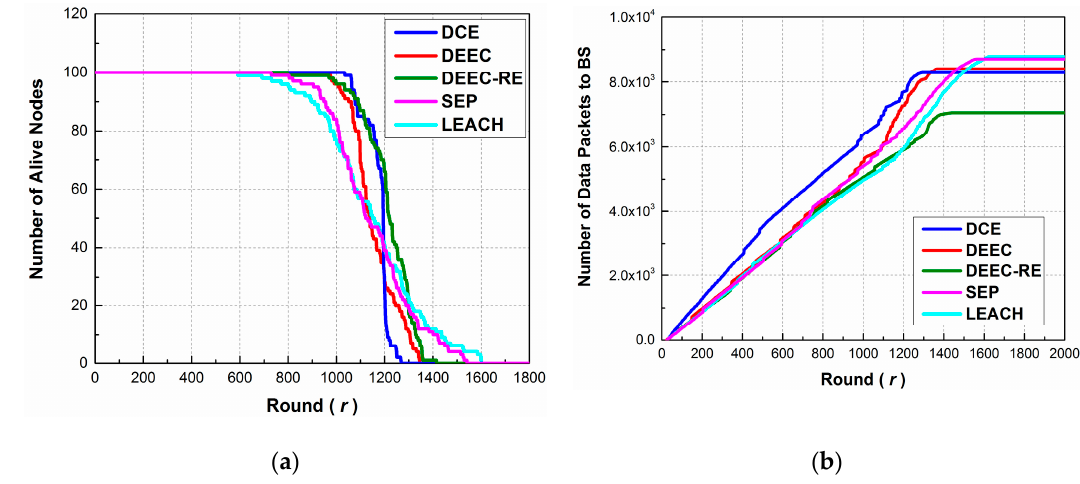
Figure 4. The performance of DCE, DEEC, DEEC-RE, SEP and LEACH in Scenario 1: ( a ) Number of Alive nodes by round; ( b ) Number of data packets to BS by round.